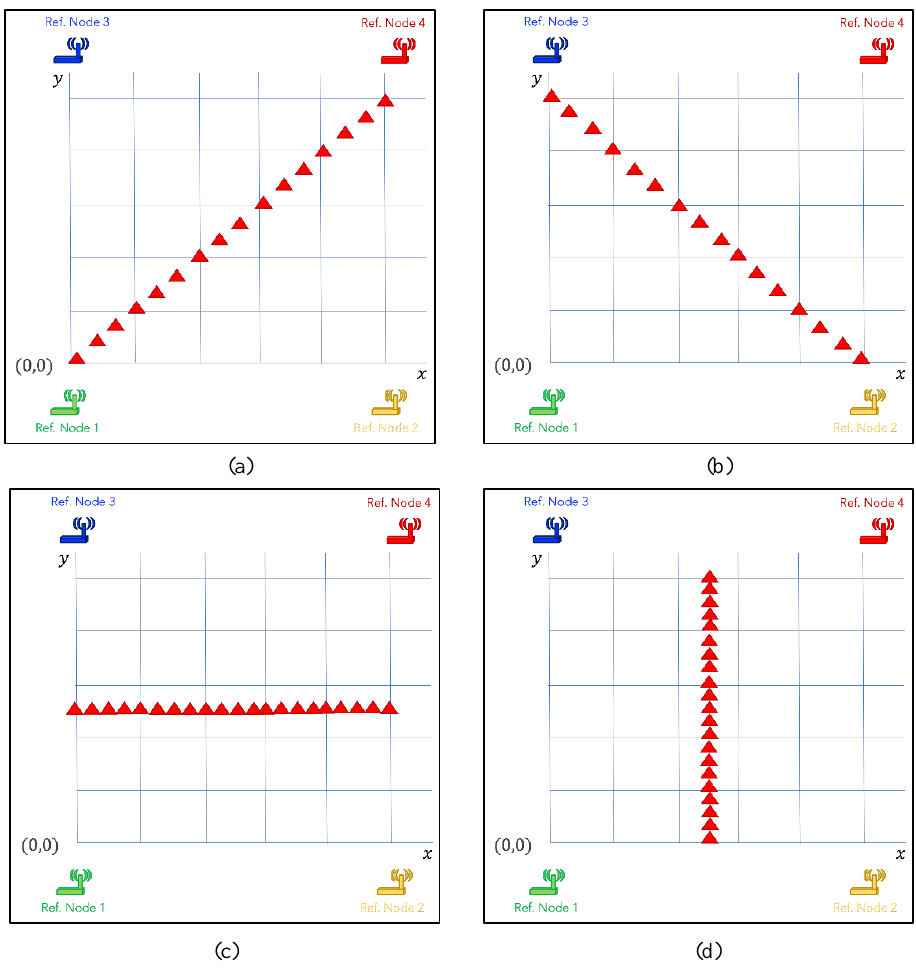
Figure 9. Target types’ position, a) type 1, b) type 2, c) type 3, d) type 4.